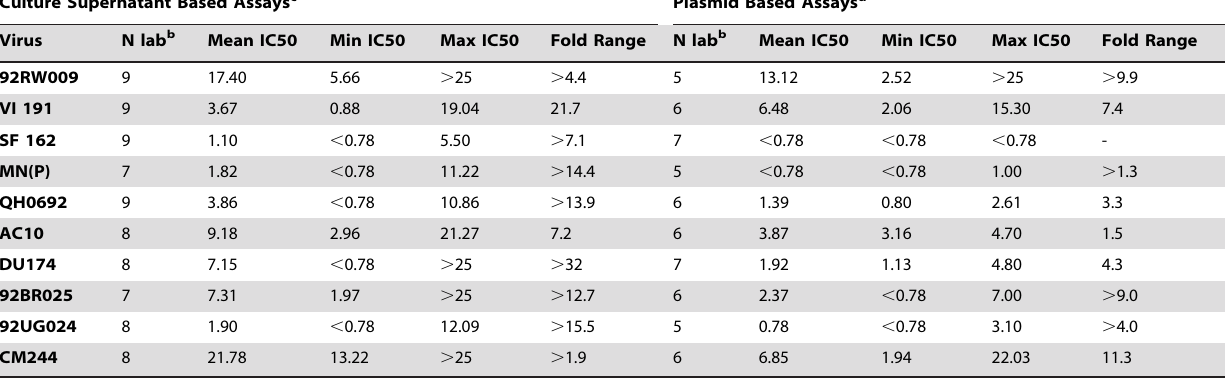
Table 3. Inter-Laboratory comparisons with TriMab a .